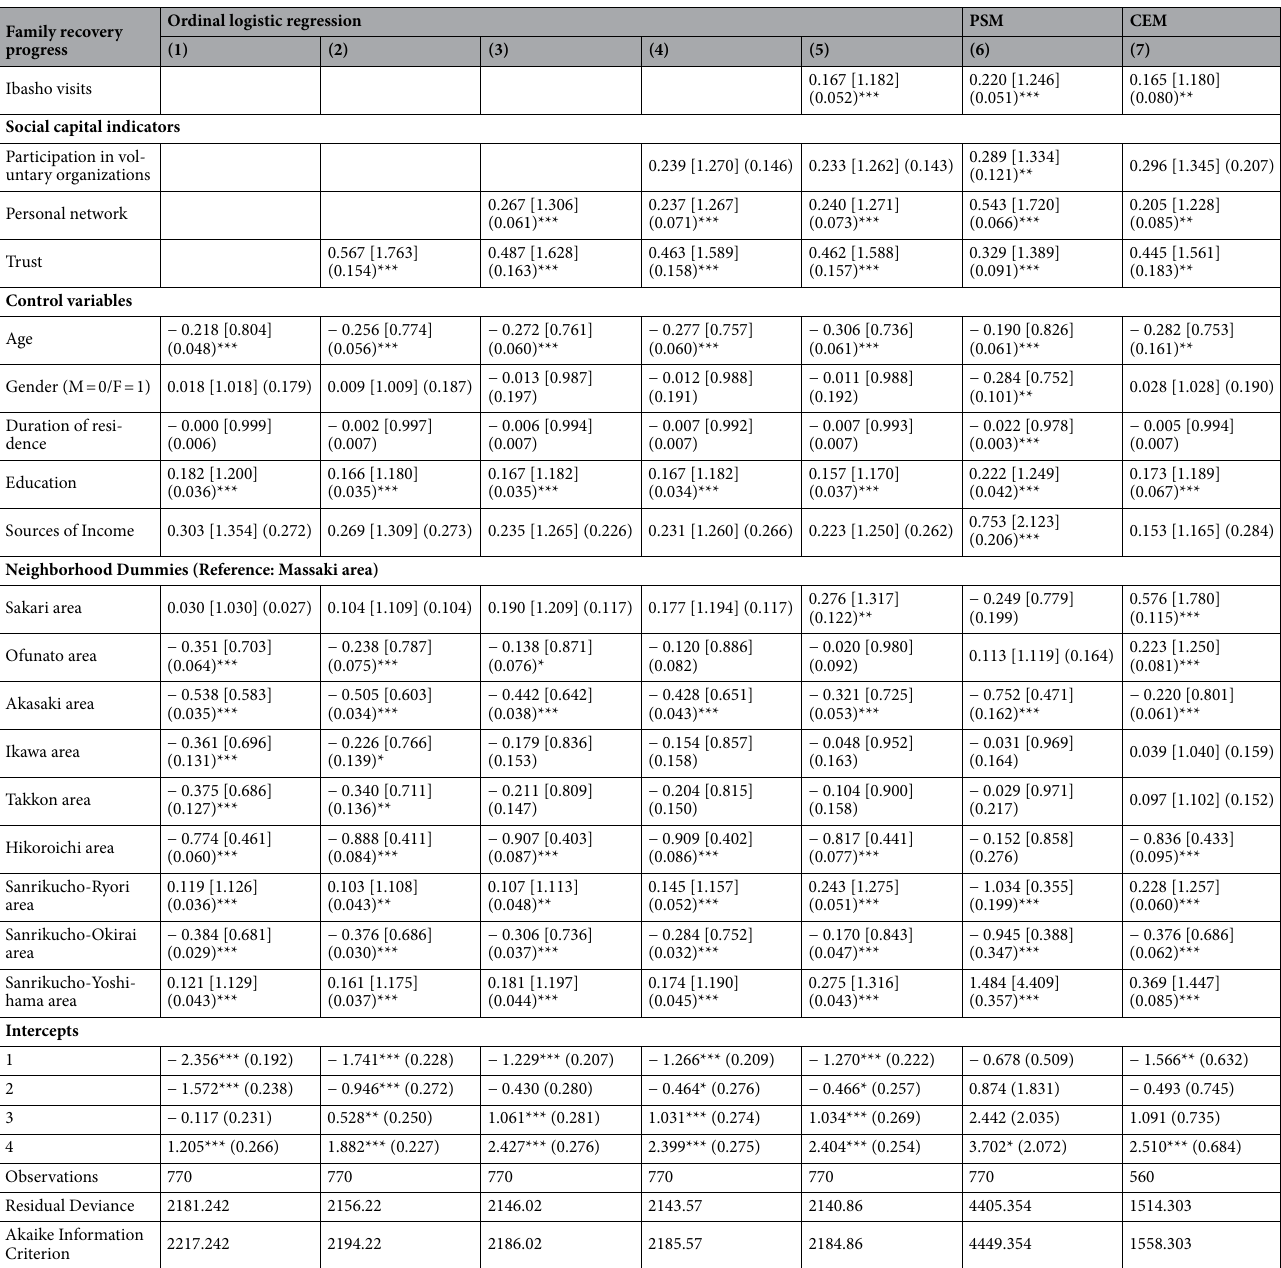
Table 3. Regression of family recovery progress on Ibasho visits and social capital indicators. *p < 0.1; **p < 0.05; ***p < 0.01; Odds ratios are reported in square brackets; standard errors (in parentheses) are clustered by